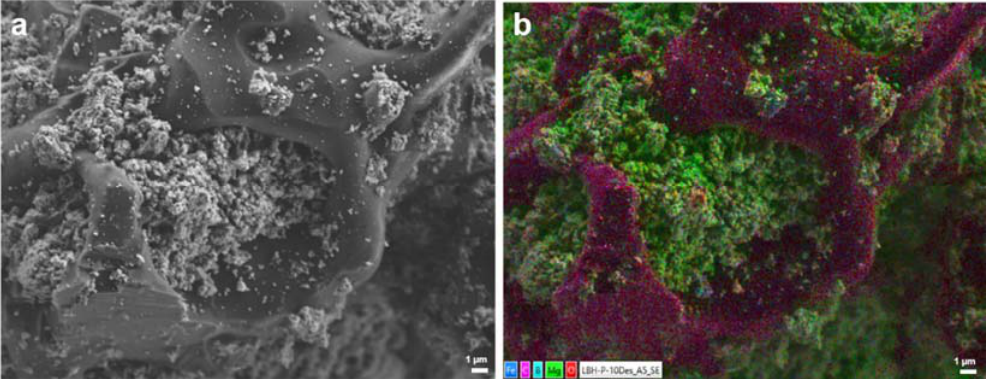
Figure 5. SEM image ( a ) and EDX elemental mapping ( b ) of the cycled RHC d + 7.5(3TiCl 3 · AlCl 3 ) + TPX TM (Fe, C, B, Mg, and